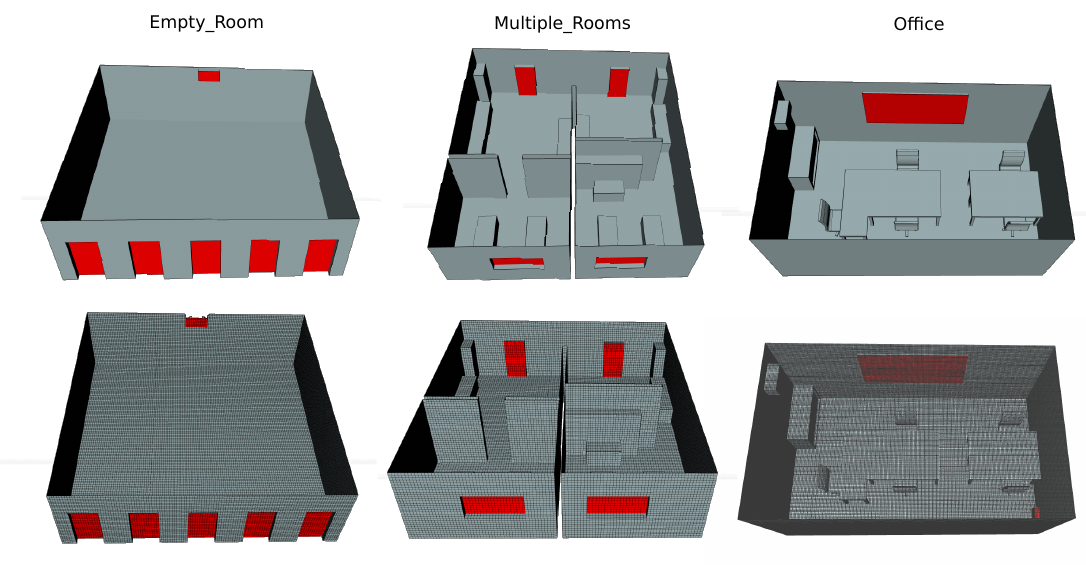
Figure 2. Three simulated environments with increasing complexity: An empty room, a multiple-room environment, and an office with tables and chairs. ( top row ) CAD models, ( bottom row ) meshes generated for their use in OpenFoam. Candidate inlets/outlets are marked in